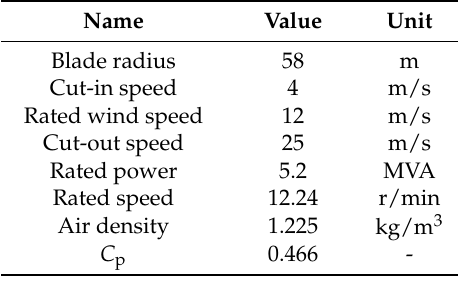
Figure 6. Simulation model of the PMSG wind power system in PSCAD. Table 1. Definition of the variables used in the wind turbine simulation